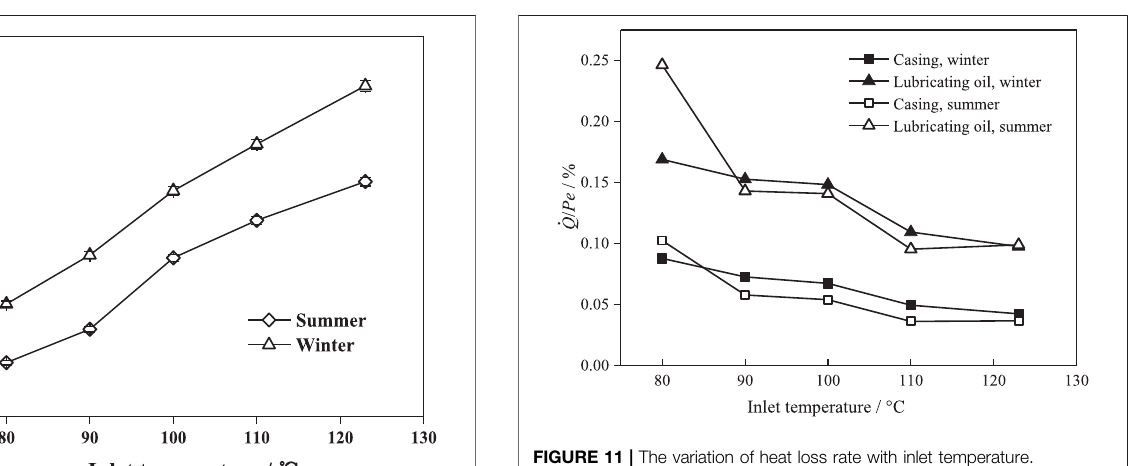
FIGURE 11 | The variation of heat loss rate with inlet